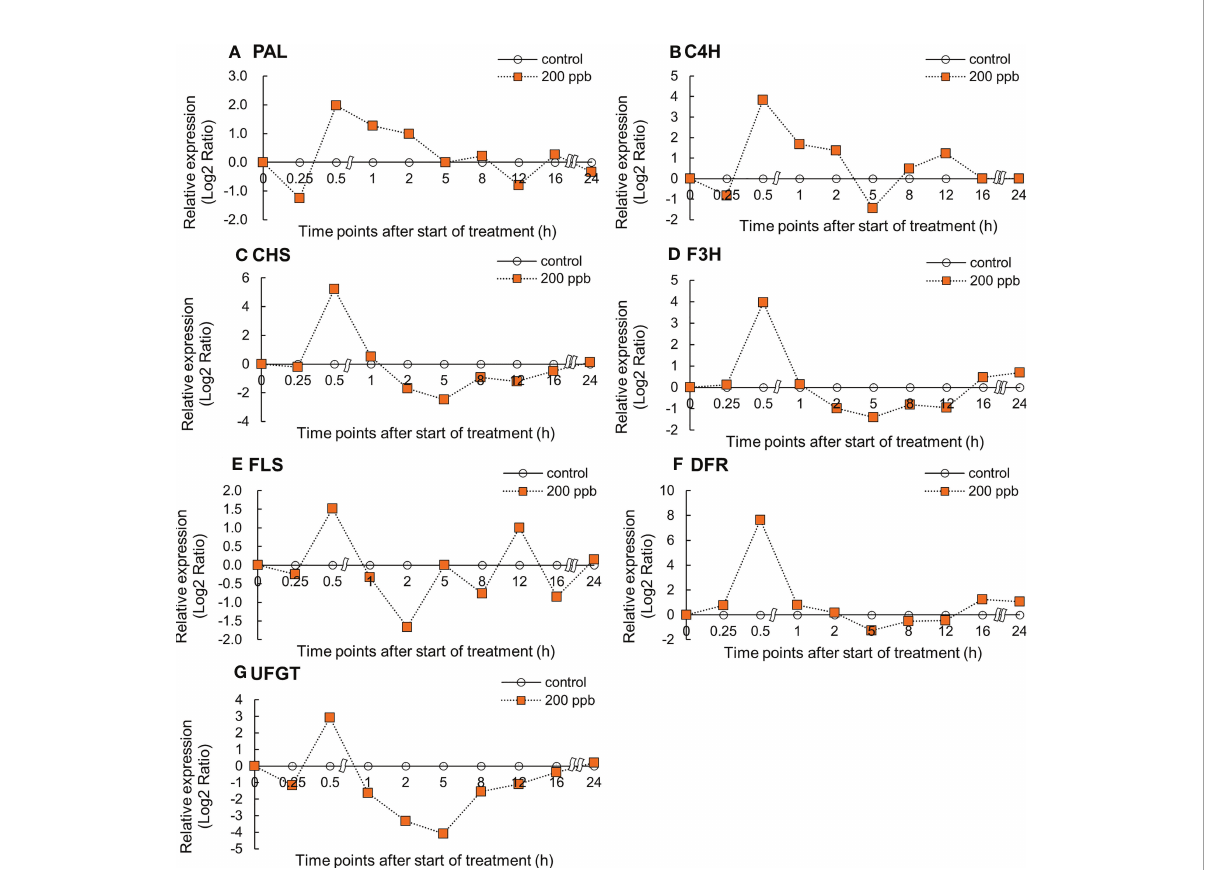
FIGURE 5 Effect of 200-ppb ozone exposure on relative gene expression (Log2 Ratio) of PAL (A) , C4H (B) , CHS (C) , F3H (D) , FLS (E) and DFR (F) , and UFGT (G) mRNA in fourth leaf of lettuce plant. The vertical vars indicate SE (n=4). The line graphs indicate Log2 fold change (treatment/control) levels of gene